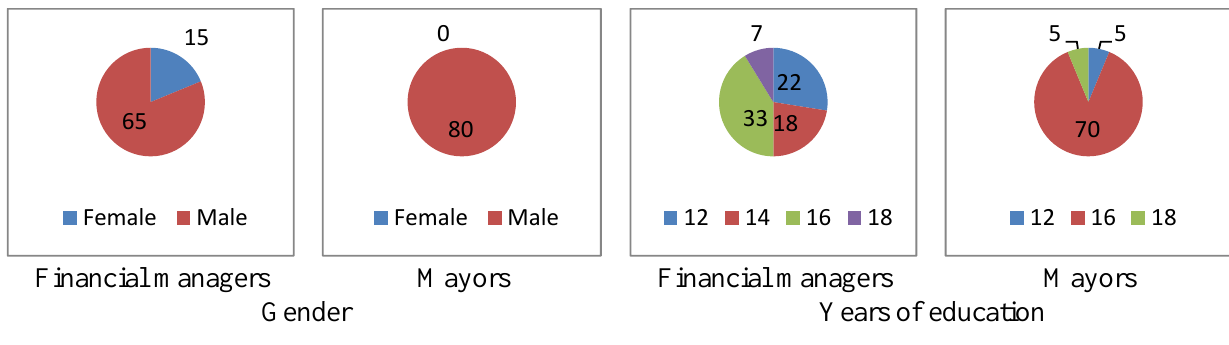
Fig. 1. Personal characteristics of the